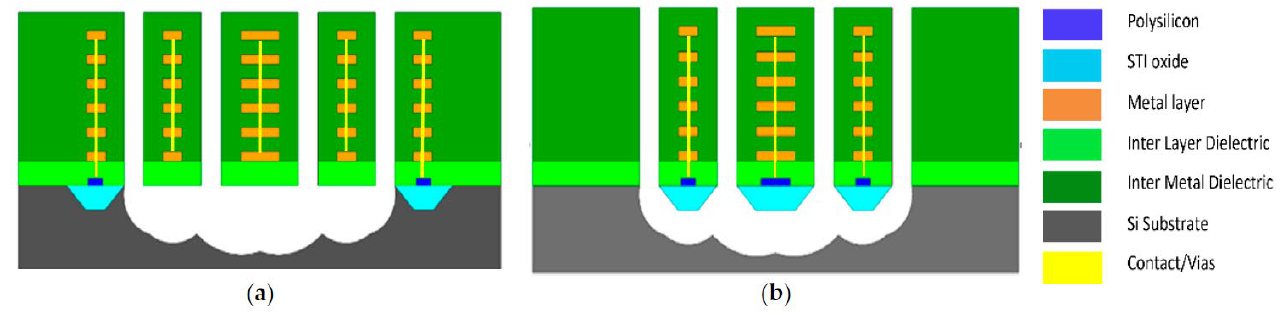
Figure 2. Chip cross sections after the current CMOS process provided by TSRI and UMC: ( a ) typical UMC 0.18 µm CMOS MEMS process with isotropic XeF 2 undercut etching for the MEMS open area; ( b ) alternative way in MEMS region using shallow-trench-isolation (STI; light blue) to protect polysilicon (dark blue) during XeF 2 etching.